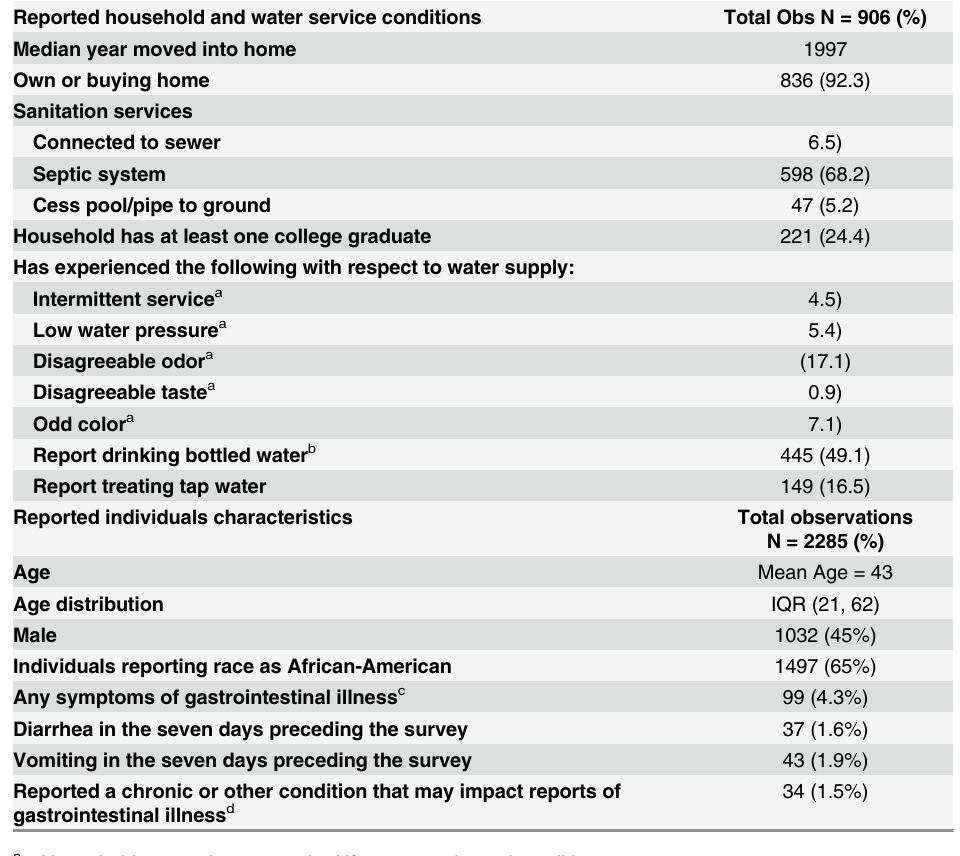
Table 1. Characteristics of Households and Participants from a Cross-sectional Study on Water Sup- ply and Health in Rural Alabama